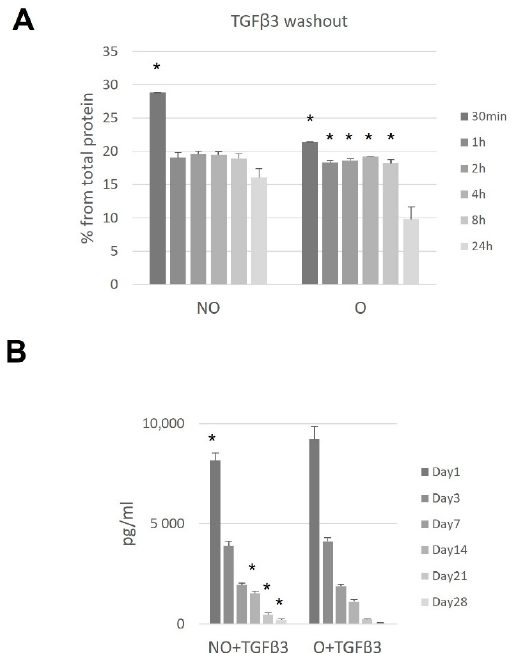
Figure 2. TGF- β 3 wash-out ( A ); TGF- β 3 release within time ( B ). Scaffolds were loaded with TGF- β 3 and tested for protein binding (n = 2) and release (n = 5) at the given timepoints. Results are pre- sented as mean +/ − standard deviation. The * represent p -value < 0.05 comparing values after 24 h as a reference level ( A ) and comparing NO + TGF- β 3 at all timepoints to O + TGF- β 3 scaffolds ( B ). NO—untreated, O—ozone-treated, TGF- β 3—transforming growth factor beta-3, min—minutes, h—hours, pg/mL—picograms per